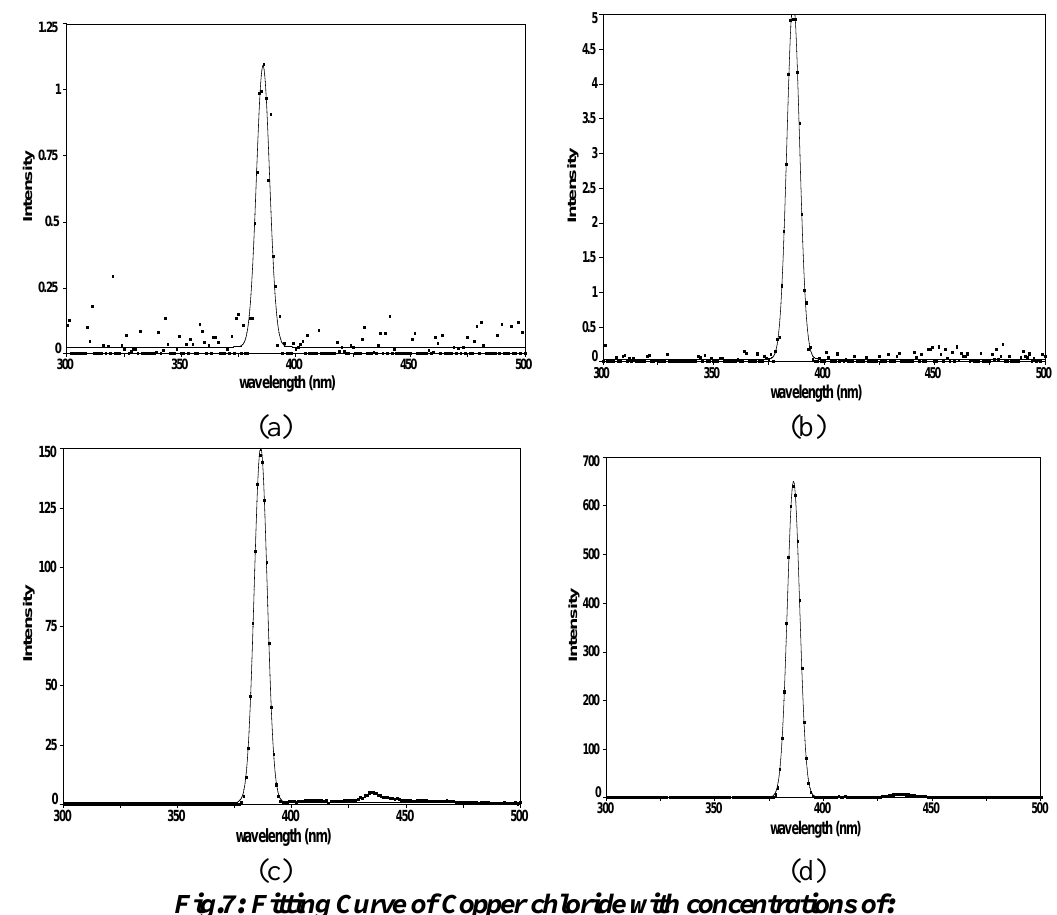
Fig.7: Fitting Curve of Copper chloride with concentrations